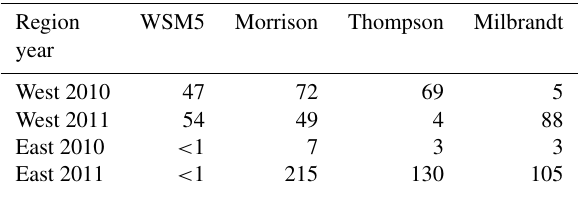
Table 5. Average ratio (%) of the number of occurrences of LWC > 0.01gkg − 1 in the simulations over the observations. The average is derived from the flight